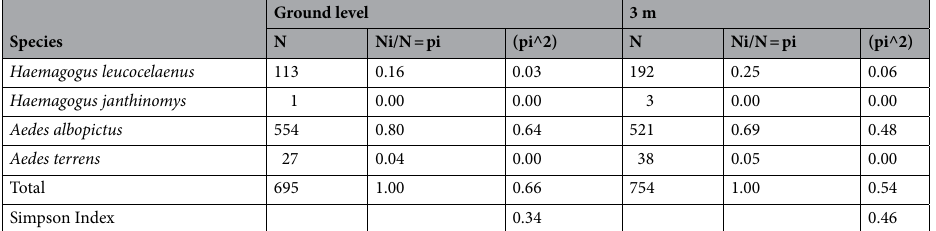
Table 2. Simpson’s index of culicids collected in Córrego da Luz, Casimiro de Abreu, Rio de Janeiro, Brazil, from July 2018 to December 2019. N, number of mosquitoes; No, number of mosquitoes of each species; pi, proportion of individuals of a species.